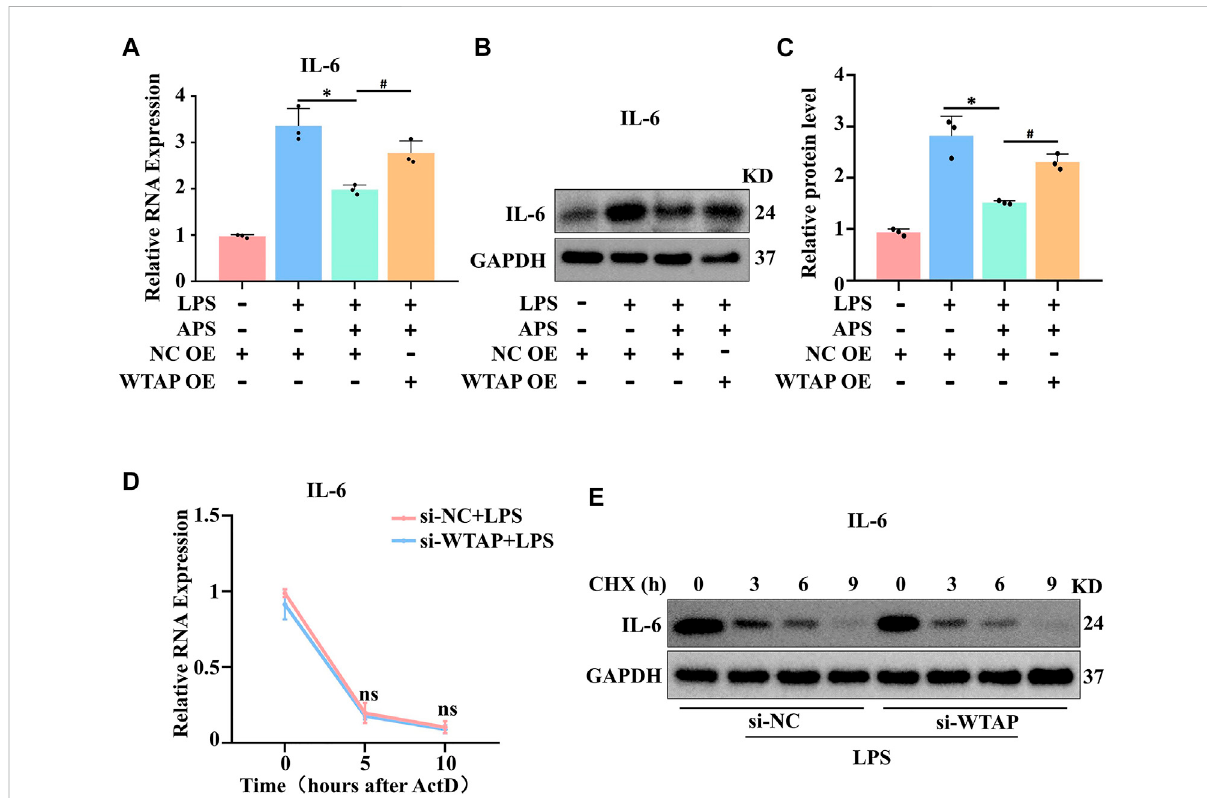
FIGURE 4 APS exerted an anti-in fl ammatory effect by regulating WTAP expression. IL-6 expression in APS-treated THP-1 macrophages after WTAP overexpression was detected by (A) qRT-PCR and (B) western blot. (C) Densitometry quanti fi cation of protein. (D) IL-6 mRNA stability following treatment with actinomycin D (ActD, 2 μ M) was detected by qRT-PCR. (E) THP-1 macrophages were treated with cycloheximide (CHX, 10 μ M) after si-WTAPtransfection.IL-6proteinwasdetectedbywesternblot.* p < 0.05comparedwithNCOE+LPSgroup. # p < 0.05comparedwithNCOE + LPS + APS group. Data represent the mean ± SEM. n = 3 per